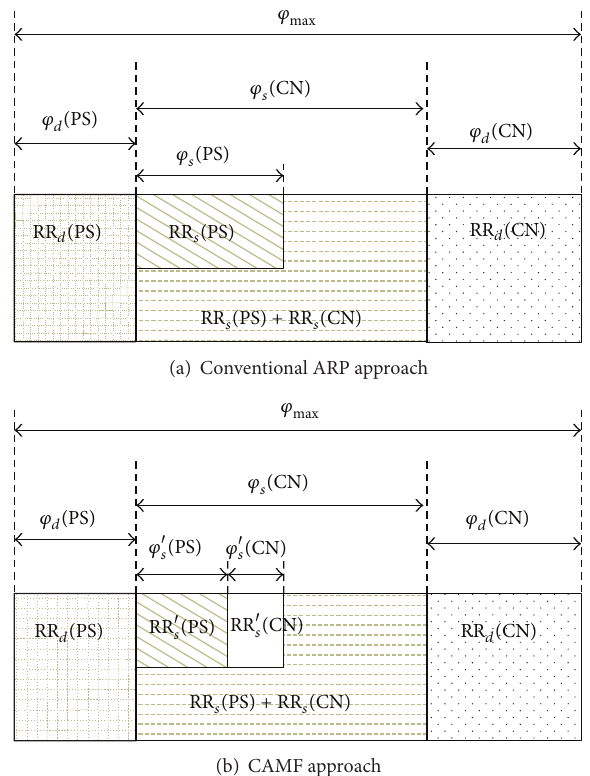
Figure 1: Courteous allocation model for